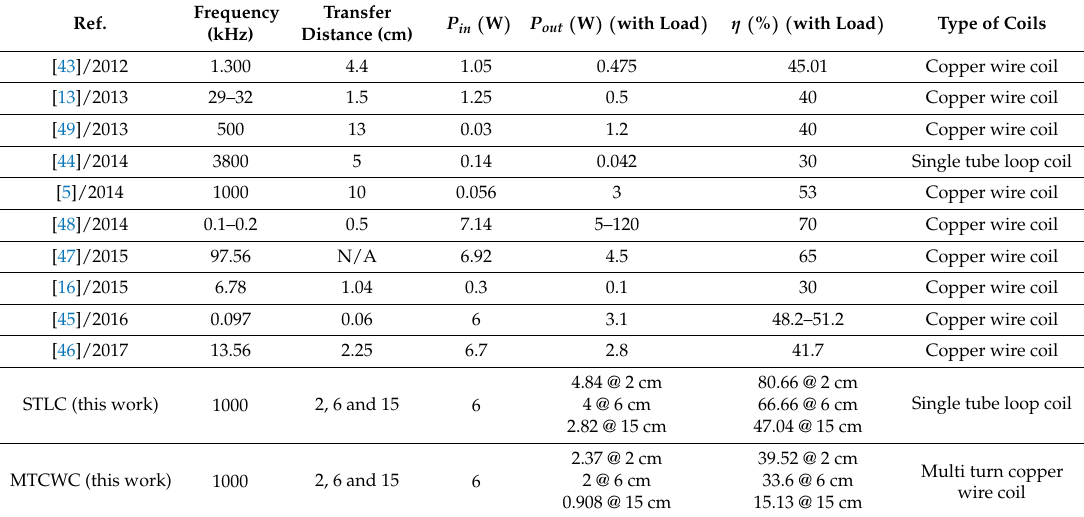
Table 4. Comparison between the two proposed systems (STLC and MTCWC) and previous systems.